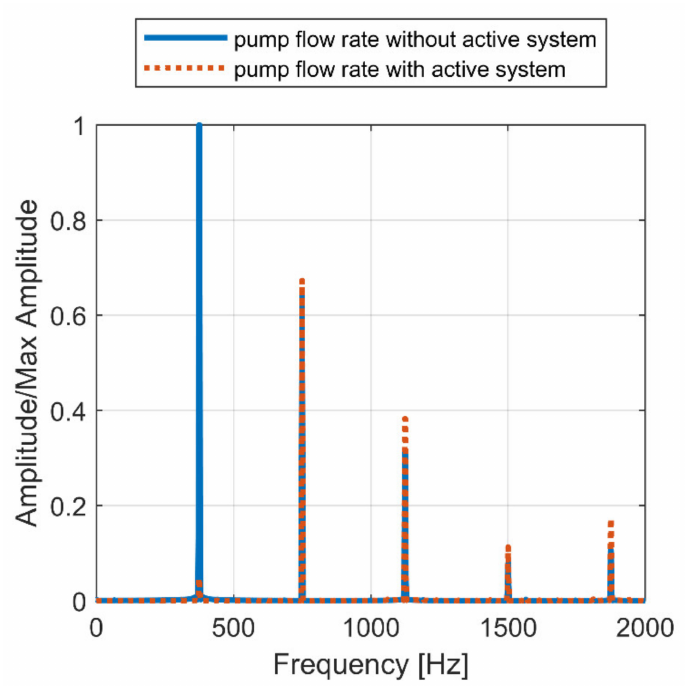
Figure 13. Simulation cycle 1, section 3: flow ripple FFT at 30 bar, 2500 rpm, 50% swash plate